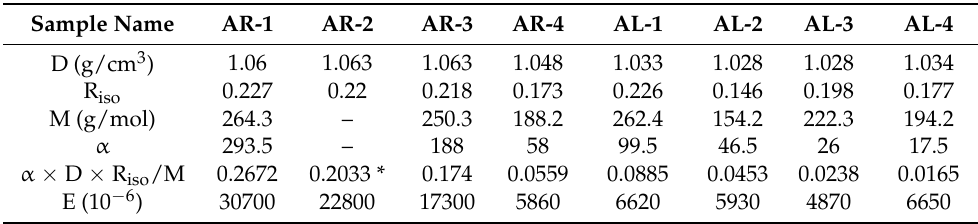
Table 5. List of densities, diisocyanate contents of polyurethanes, molecular weights, and polarizabil- ity anisotropies of the